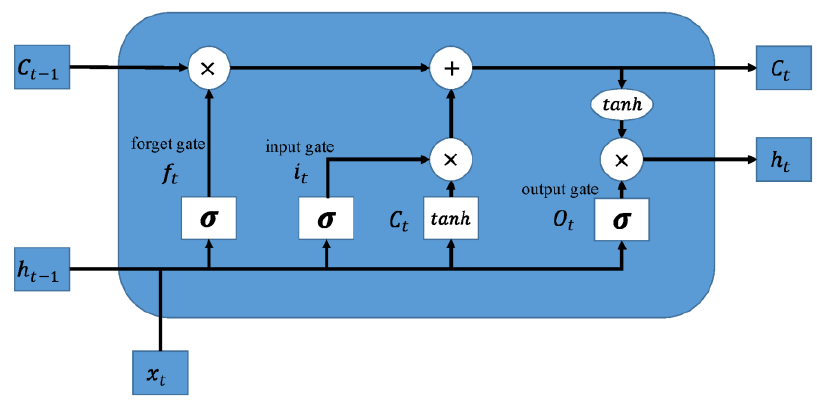
Figure 6. Long short-term memory network structure [105].